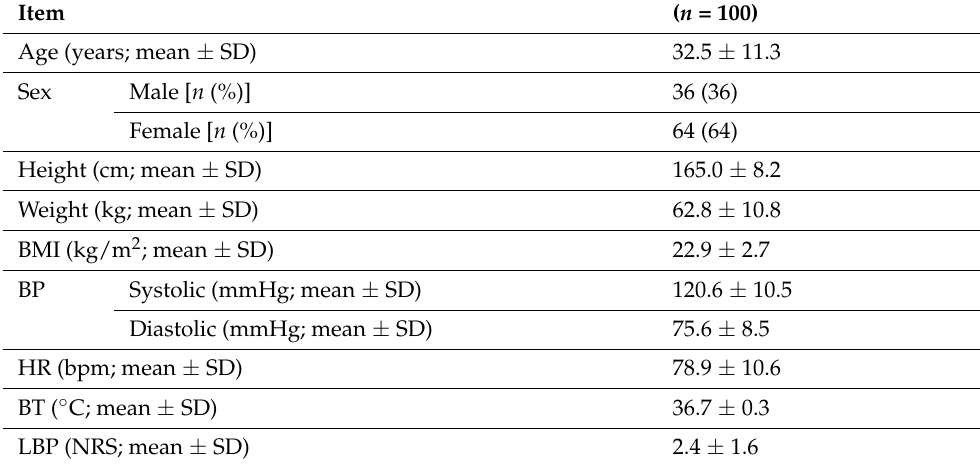
Table 1. Demographic characteristics of